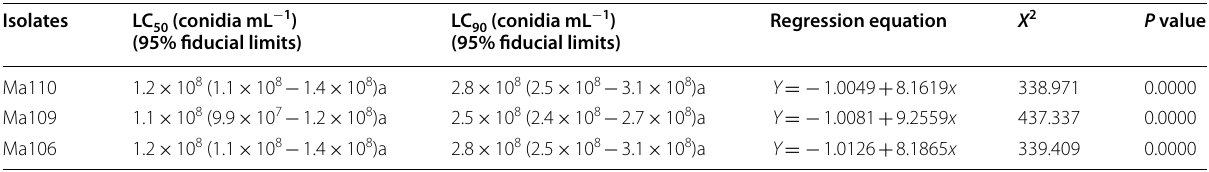
Different letters indicate significant differences according to the overlap of the fiducial limits